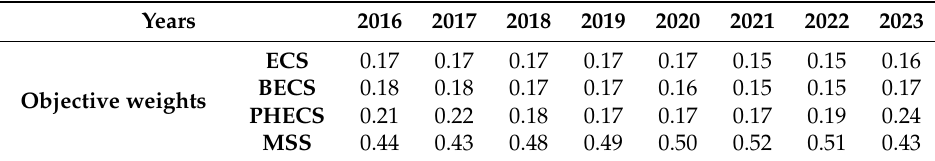
Table 11. Objective